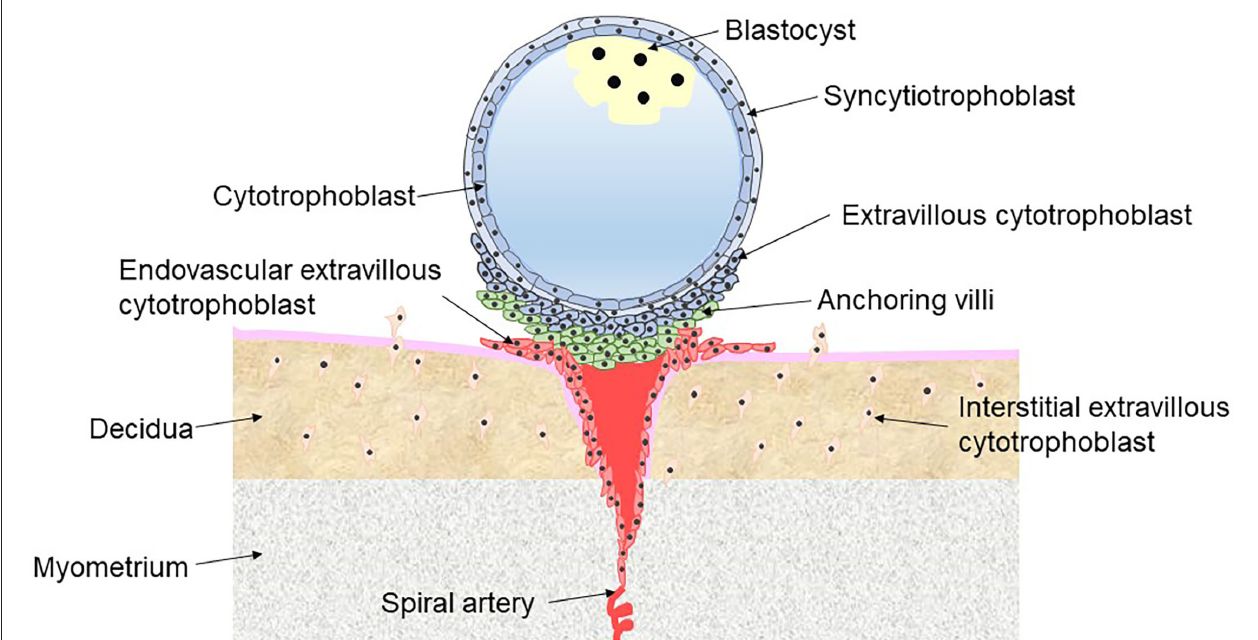
FIGURE 1 | Different types of trophoblast in placental